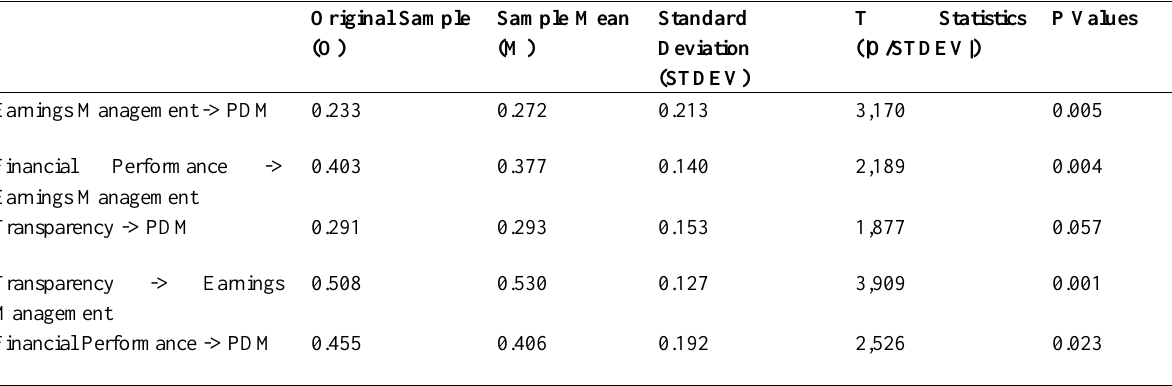
Table 7: Path Coefficients (Mean, STDEV,